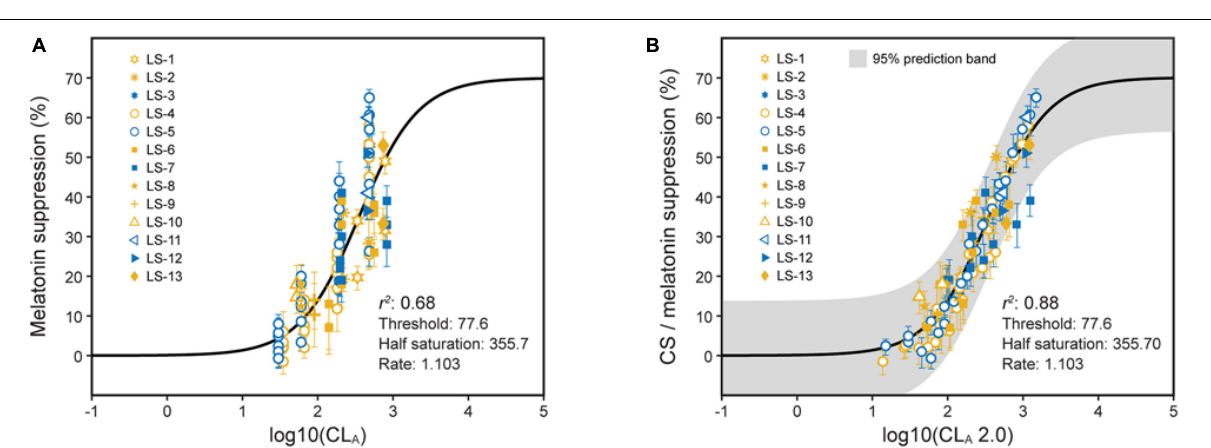
FIGURE 8 | Nocturnal melatonin suppression as a function of log CL A (A) and log CL A 2.0 (B) . (A) Includes the predictions from the 2005 model (Eqs. 1 and 2, solid line) and (B) includes the CS t , f predictions from the revised model (Eqs. 3 and 5, solid line). The legend entries in both panels correspond to the light source designations in Supplementary Table 1 and Supplementary Figure 1 . Blue symbols are associated with light sources where b-y > 0 and yellow symbols for light sources where b-y ≤